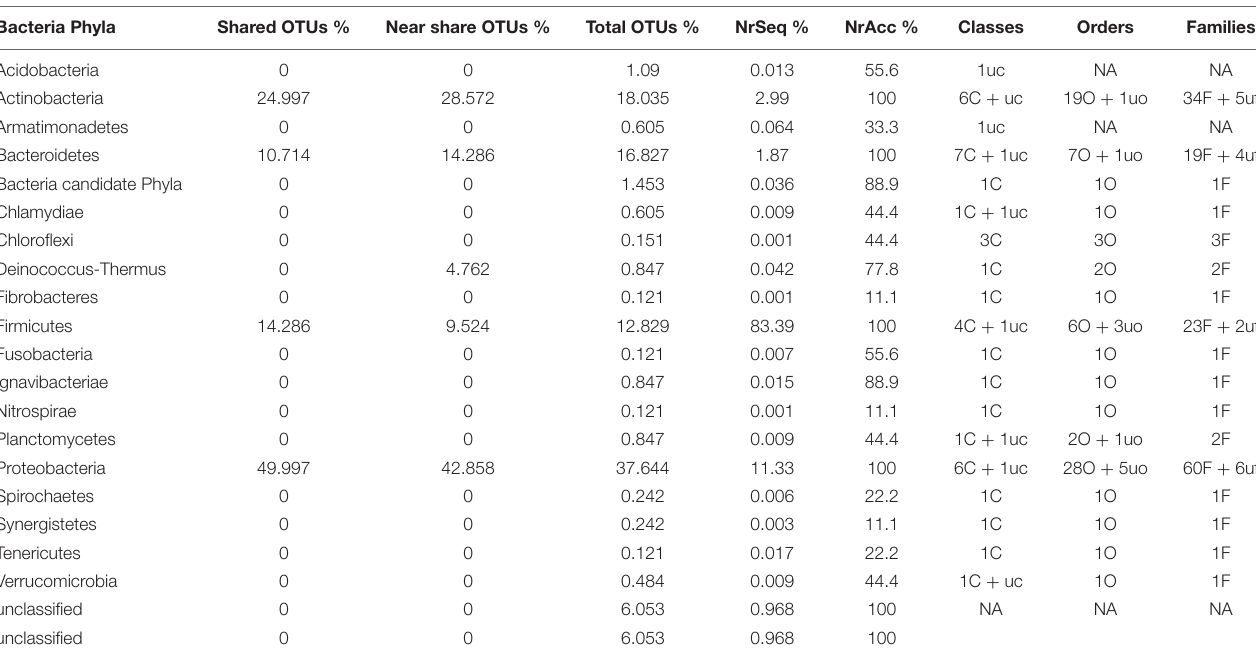
FIGURE 2 | Rarefaction curves for OTU (A) and Shannon-Index (B) of leaf-associated bacterial communities in nine accessions of Asplenium delavayi . The X -axis shows the number of reads, whereas Y -axis shows the accumulation of the number of OTUs, and the increase of Shannon Index, respectively, for each of the nine accessions studied. Endpoints of graphs correspond to the number of reads per sample. TABLE 3 | Summary of the phyla diversity observed in Asplenium delavayi